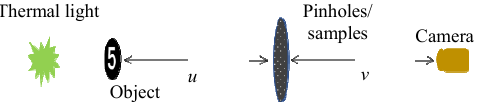
Fig. 1 Configuration of the system in both simulation and experiment. u =8 cm, v =4 cm. In experiment, a light emitting diode (LED) (Thorlabs M530L3) coupled with a 1-nm-linewidth filter is used as the illumination source. The charge-coupled device (CCD) camera (AVT Stinggray F-504B) has a pixel pitch of 3.45 